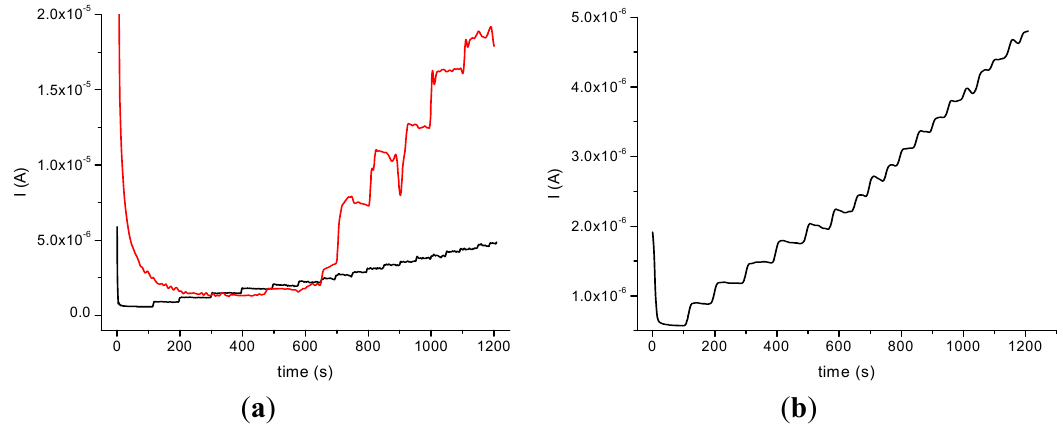
Figure 4. Acetaminophen amperograms at GCEs modified with HRP/MWCNT (type 1) immobilized in Ppy (black) and PEI (red) nanocomposite films ( a ). Detailed version of acetaminophen amperogram at GCEs modified with HRP/MWCNT (type 1) immobilized in Ppy ( b ); (HRP concentration: 0.3 mg·mL − 1 PEI 1 mg·mL − 1 ), after the addition of constant volumes (20 µL) of 10 − 2 M acetaminophen solution in PBS (pH 7.4; 0.1 M) in the presence of 0.2 mM H O 2 2